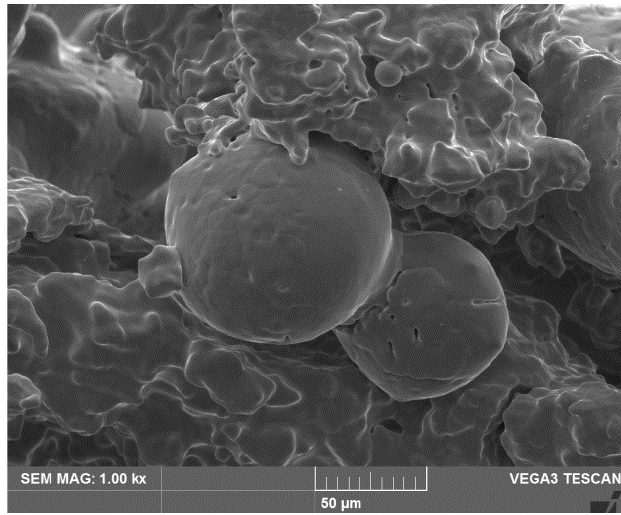
Figure 6. Filter fracture surface detail.